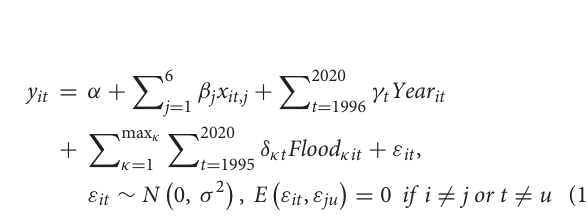
FIGURE 3 | Spatial distribution of properties for which values were published in